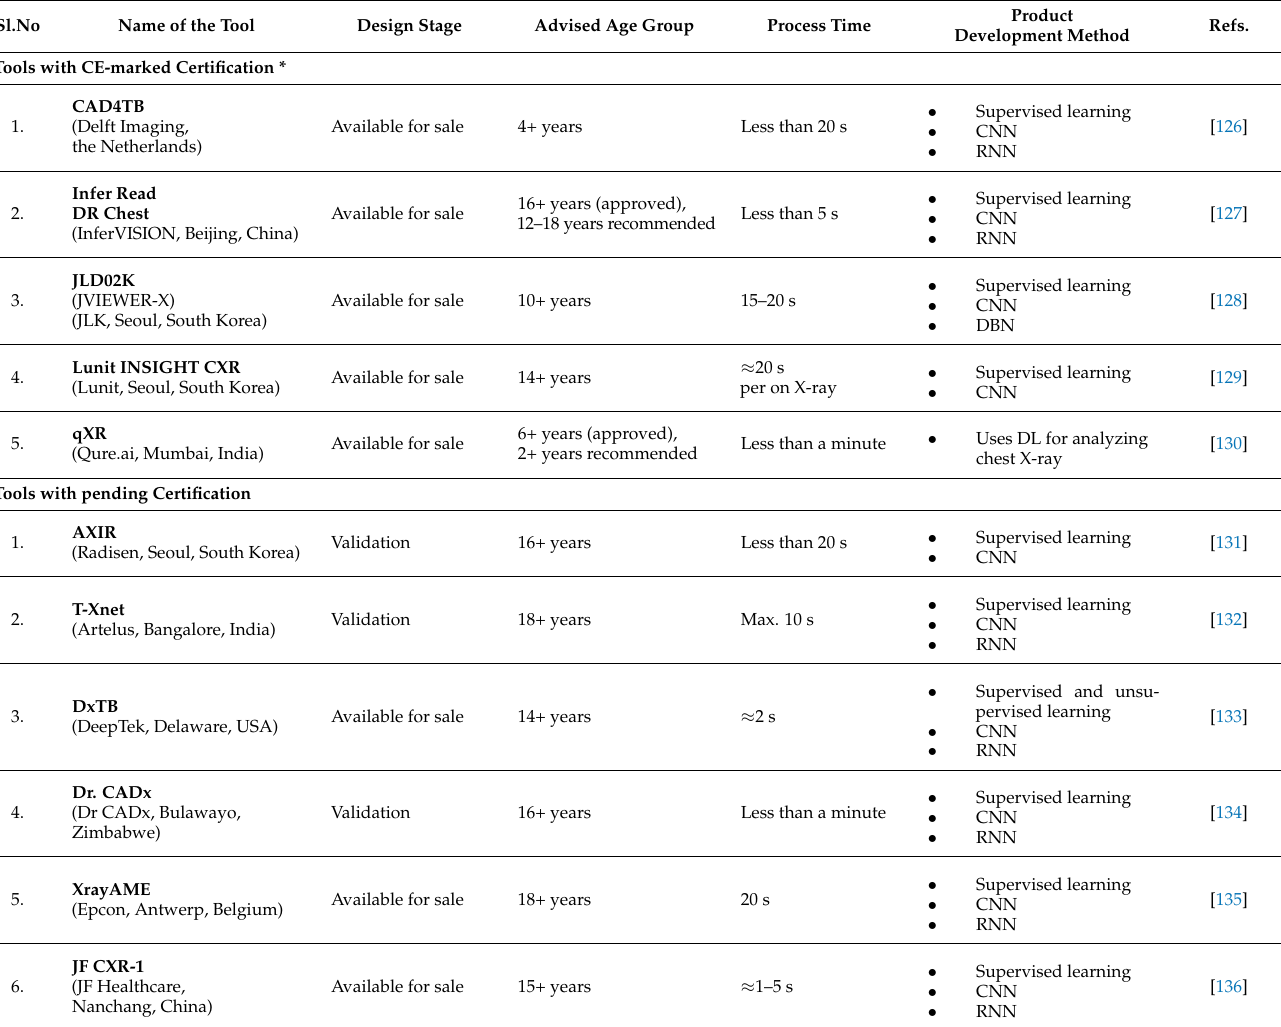
Table 4. Available and upcoming TB diagnostic tools built using the deep learning